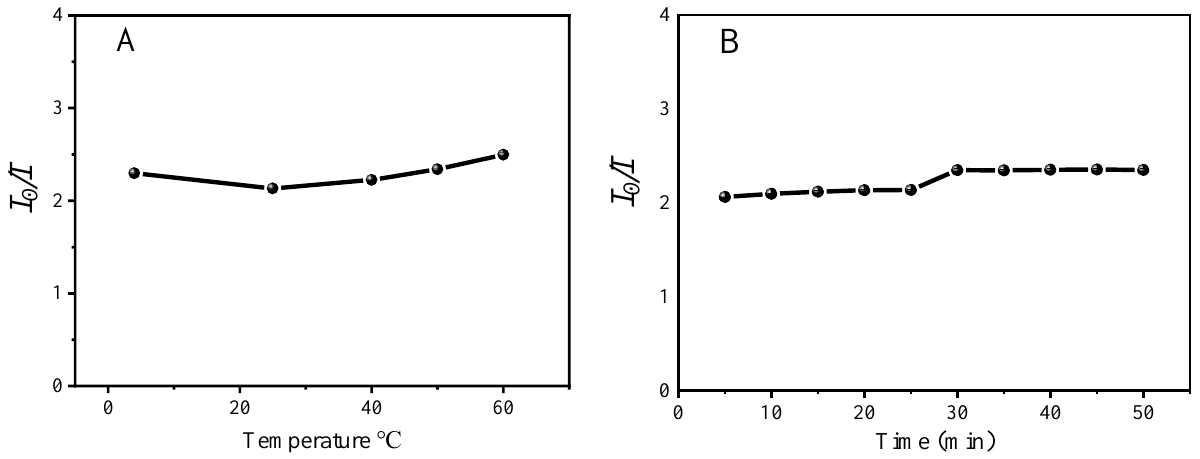
Figure 6. Optimization of temperature ( A ) and time ( B ) for the detection of FA by CsPbBr 3 /Cs 4 PbBr 6 PNCs. Experimental conditions: the concentration of CsPbBr 3 /Cs 4 PbBr 6 PNCs is 0.156 mmol; in terms of Cs atoms, the concentration of FA is 200 μM; ( A ) reaction temperature: 4 – 60 °C; reaction time: 15 min; ( B ) reaction temperature: 25 °C, reaction time: 5 – 50 min.